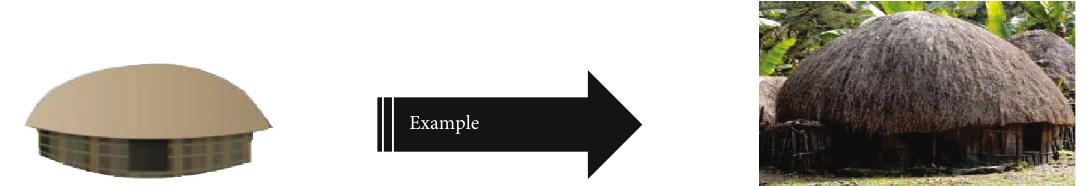
Figure 35: House diagrams of simple house VII.